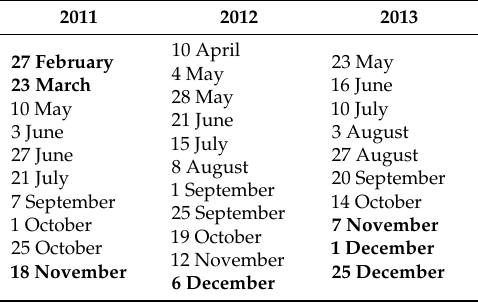
Table 1. The 2011–2013 dates of Spotlight mode acquisition. Dates with below-freezing temperatures are shown in bold. Data characteristics: polarization, HH; range resolution, 1.6 m; azimuth